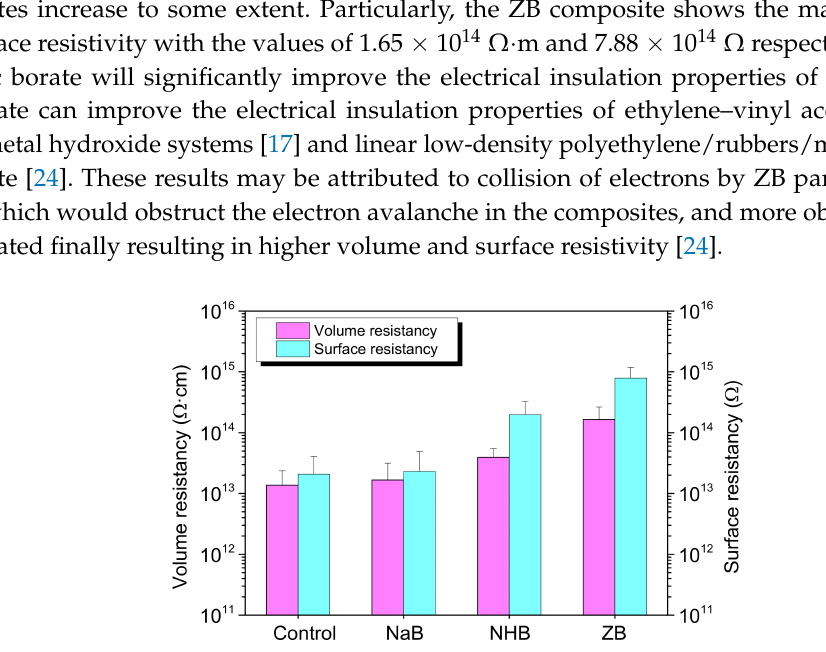
Figure 4. Electrical insulation properties of ceramizable MVQ/HNT composites with the addition of different borates.